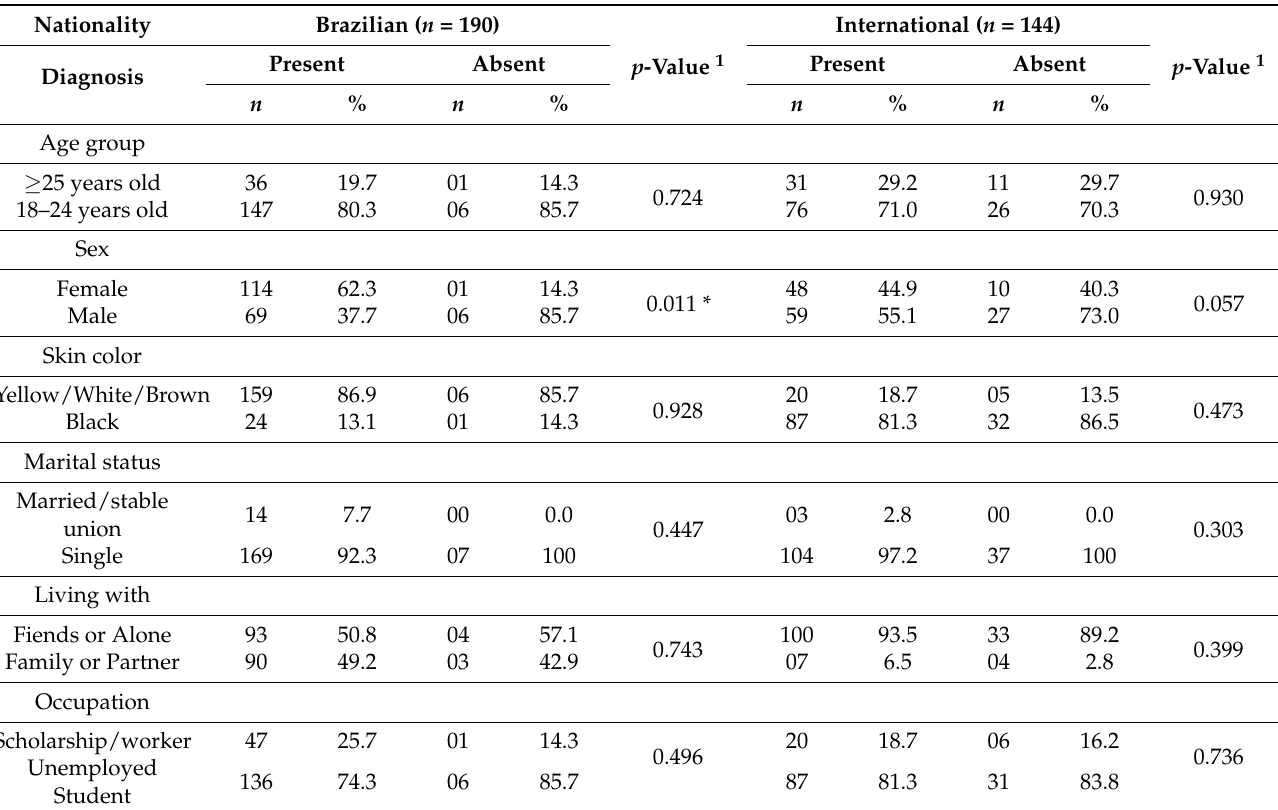
Table 4. Sociodemographic characteristics associated with the nursing diagnosis “risk of impaired cardiovascular function” in university students, according to